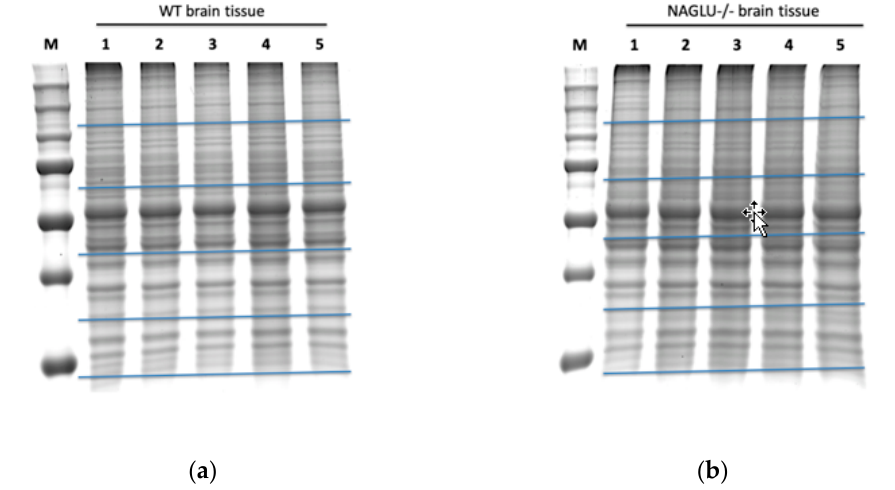
Figure 1. SDS–PAGE of proteins from murine WT (wild type) and NAGLU − / − ( α -N-Acetylglucosaminidase) brain tissues. Proteins from five murine WT brains ( a ) and five murine NAGLU − / − brains ( b ) were resolved on a 10% SDS–polyacrylamide gel and stained by a gel code blue stain reagent. Each gel lane was fractionated at the level of the blue horizontal bars in order to obtain five gel bands per sample.